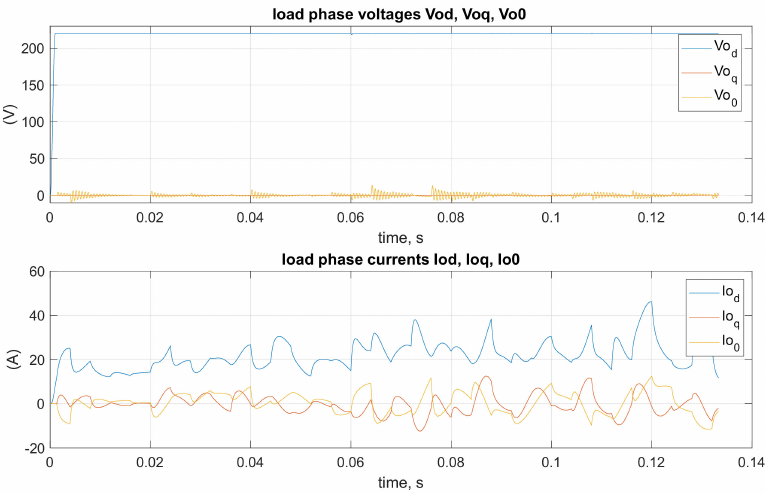
Figure 7. Load voltage V o maintaining symmetry despite random load I o in the dq coordinate